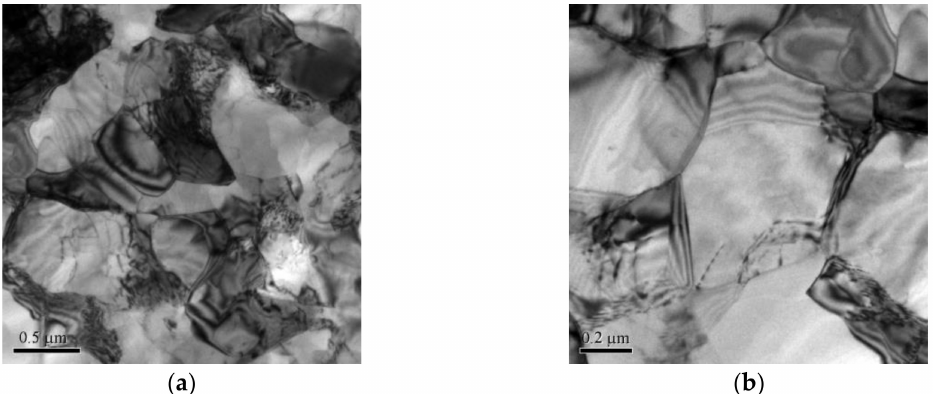
Figure 6. TEM images of alloy N2 at 80% cold rolling reduction. ( a ) with 5000 times magnification and ( b ) with 9900 times magnification.